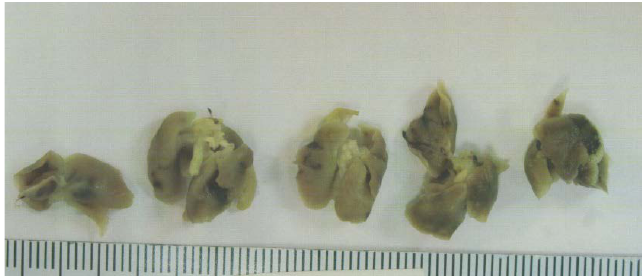
Figure 4. Lung metastasis in Control group: gross photographs.